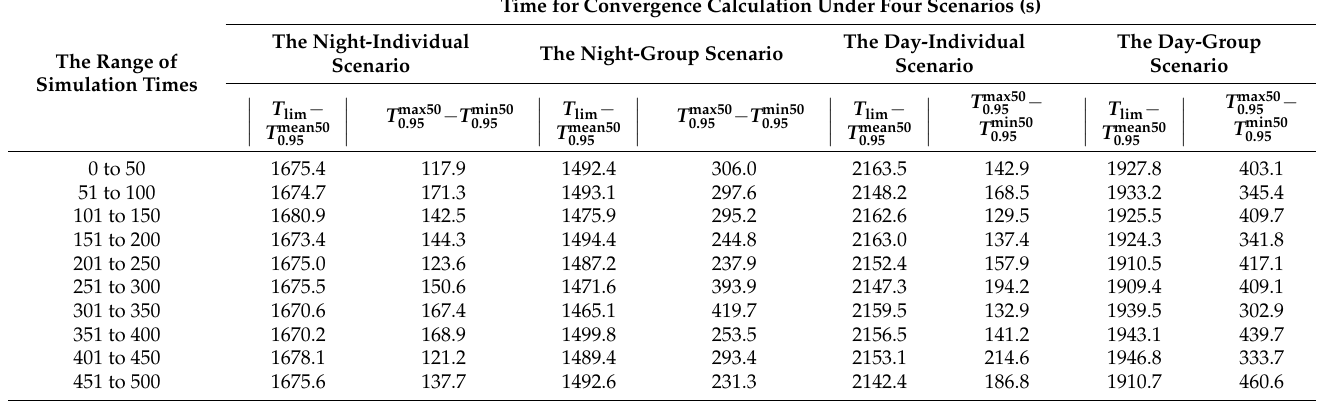
Table 3. The convergence test of the evacuation